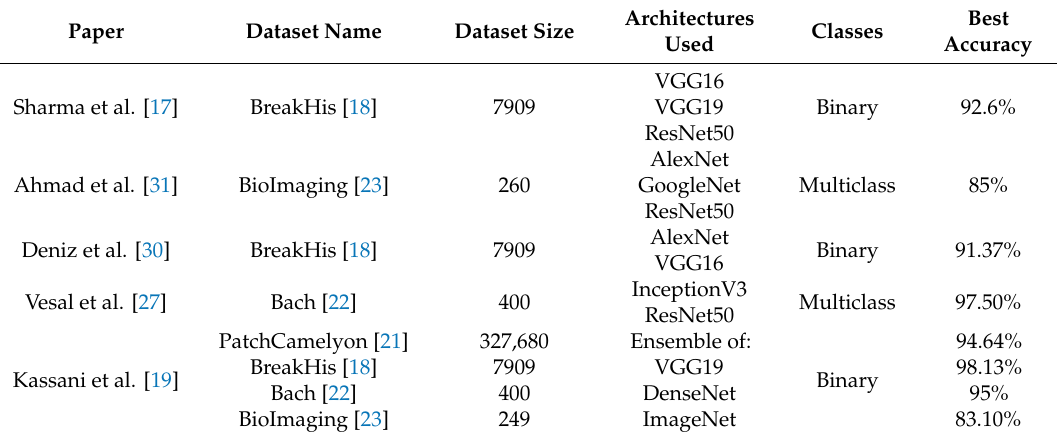
Table 1. Summary of the studies